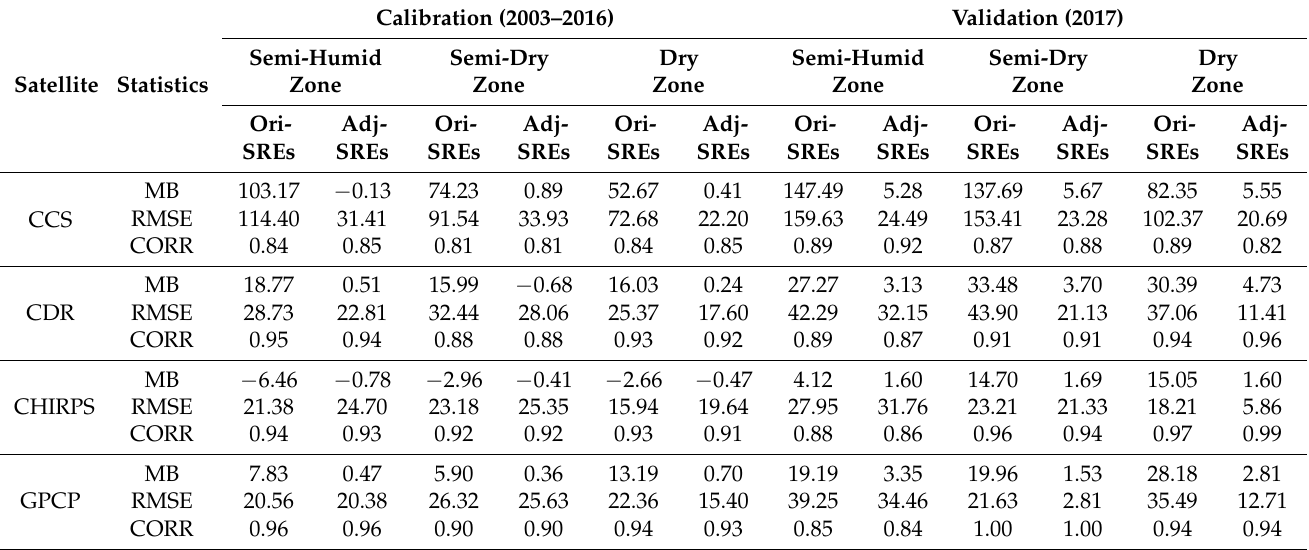
Table 2. Monthly time series evaluation